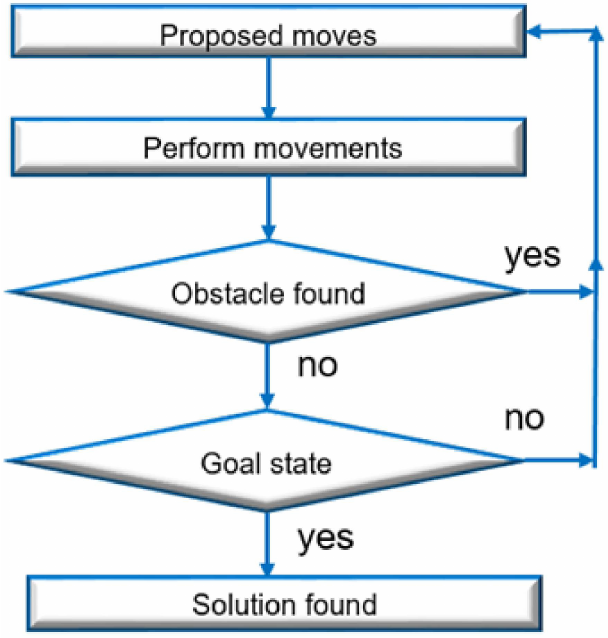
Figure 1. Flowchart for trajectory planning of mobile